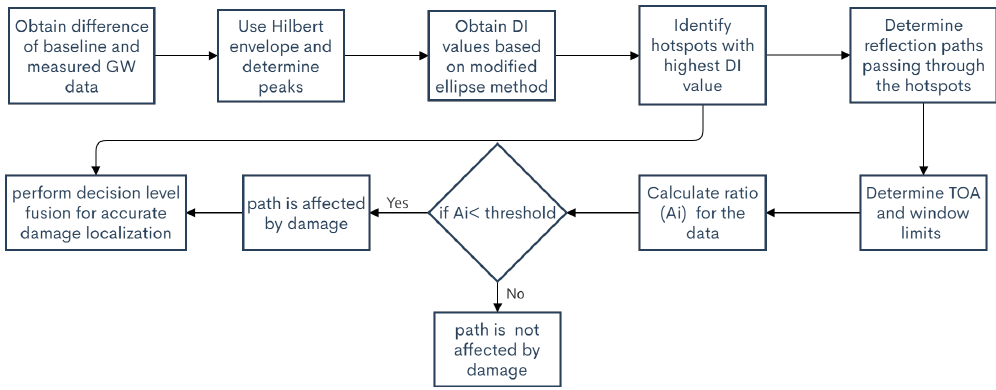
Figure 5. Flowchart of two step